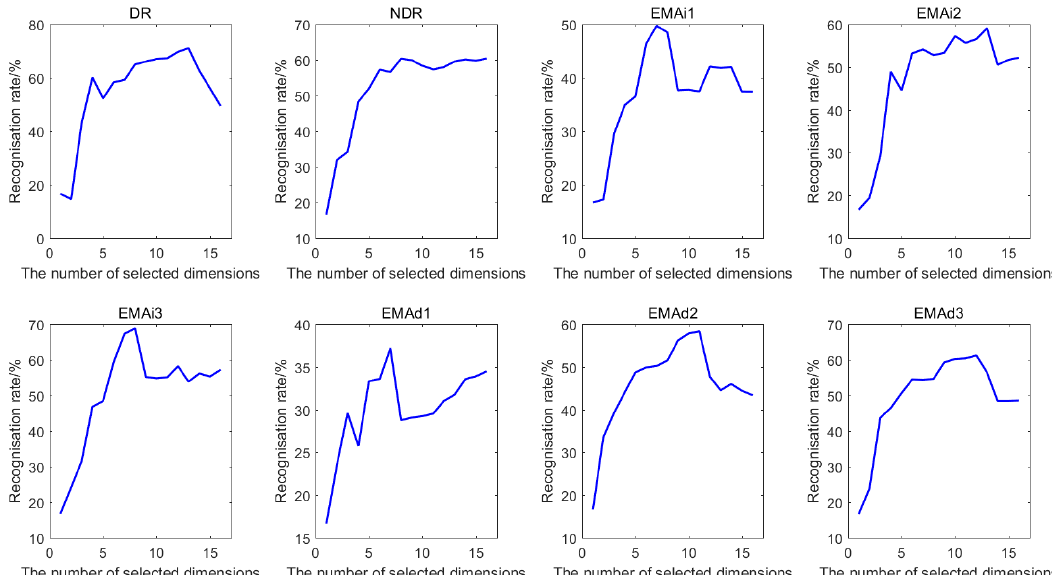
Figure 5. The classification accuracies of eight features for Dataset II.